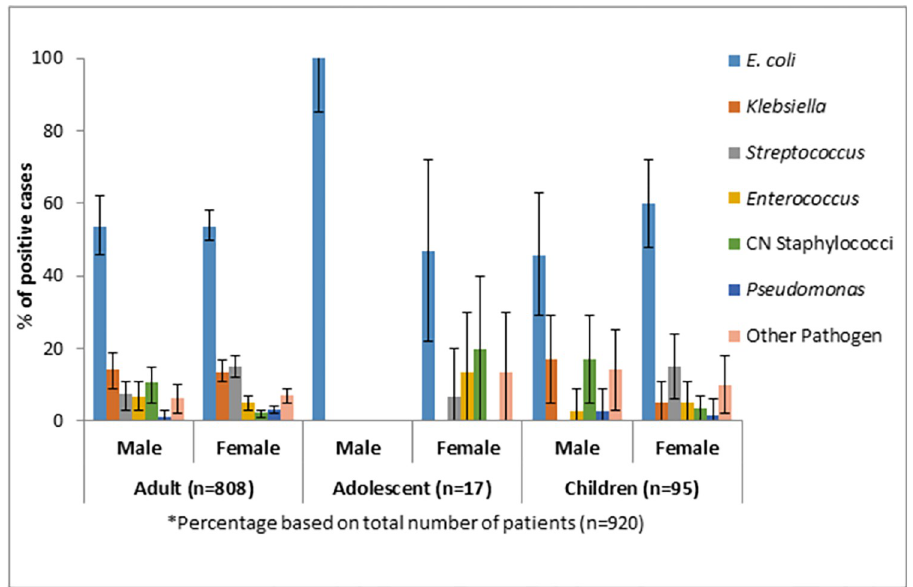
Fig 3. Distribution of the prevalence of major pathogens causing CA-UTI among patients by age and sex.